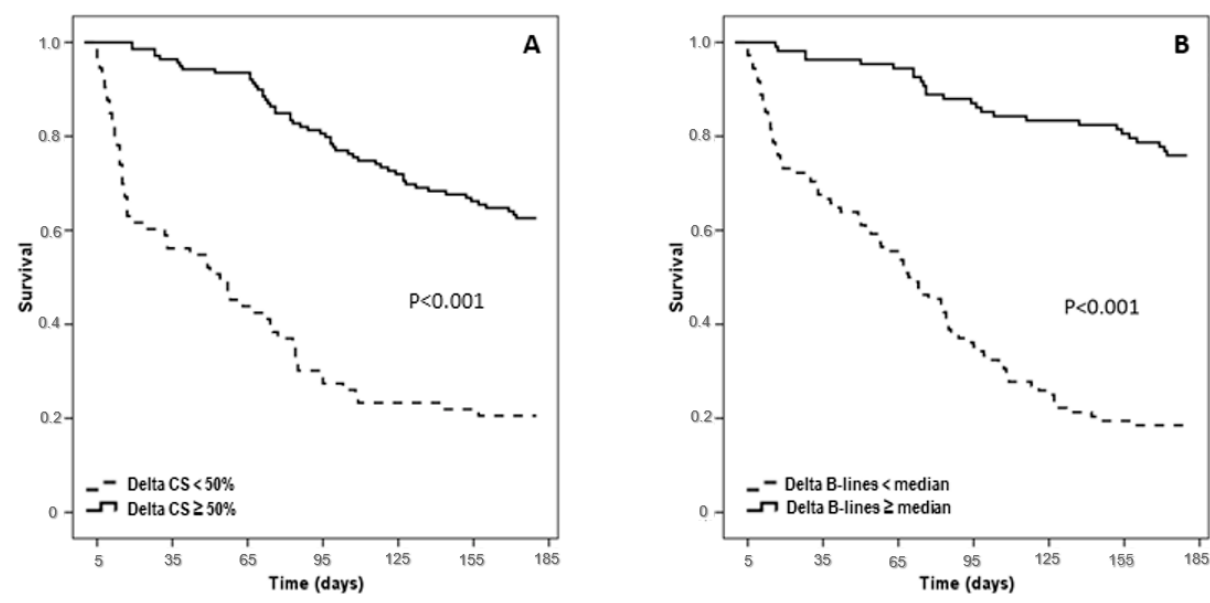
Figure 3. Kaplan-Meyer curve of median Δ Congestion score (CS) ( A ) and Δ B-lines ( B ) during